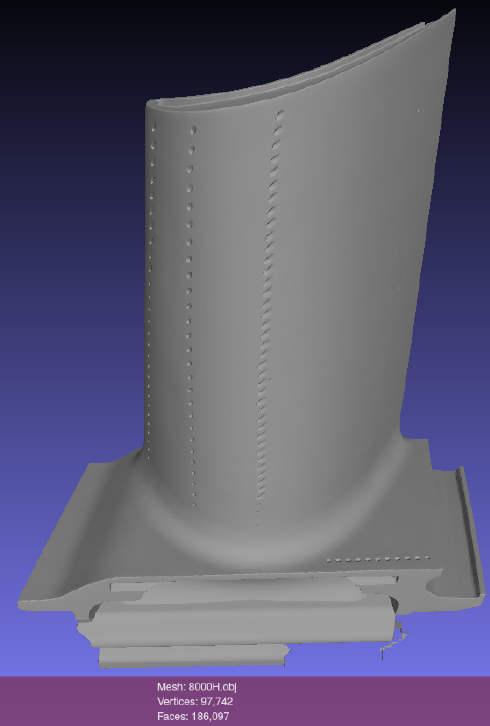
Figure 2. 3D model of a turbine blade, obtained from an industrial 3D